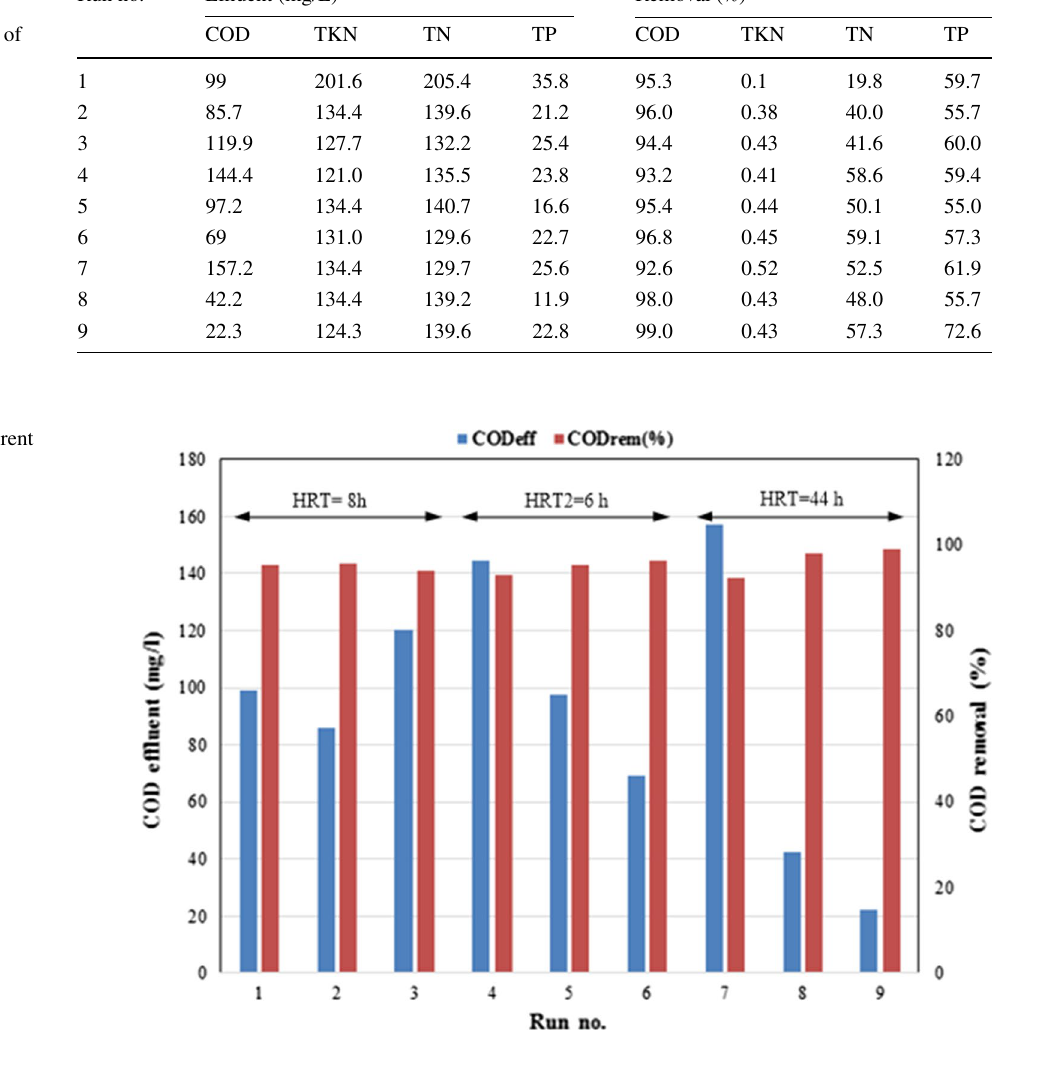
Table 3 indicates the average removal efficiency of the main physicochemical parameters of the bioreactor efflu- COD concentration and the respective removal efficiency